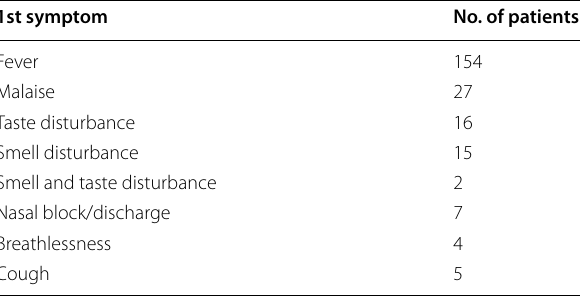
Table 4 Symptoms of patients at the time of presentation